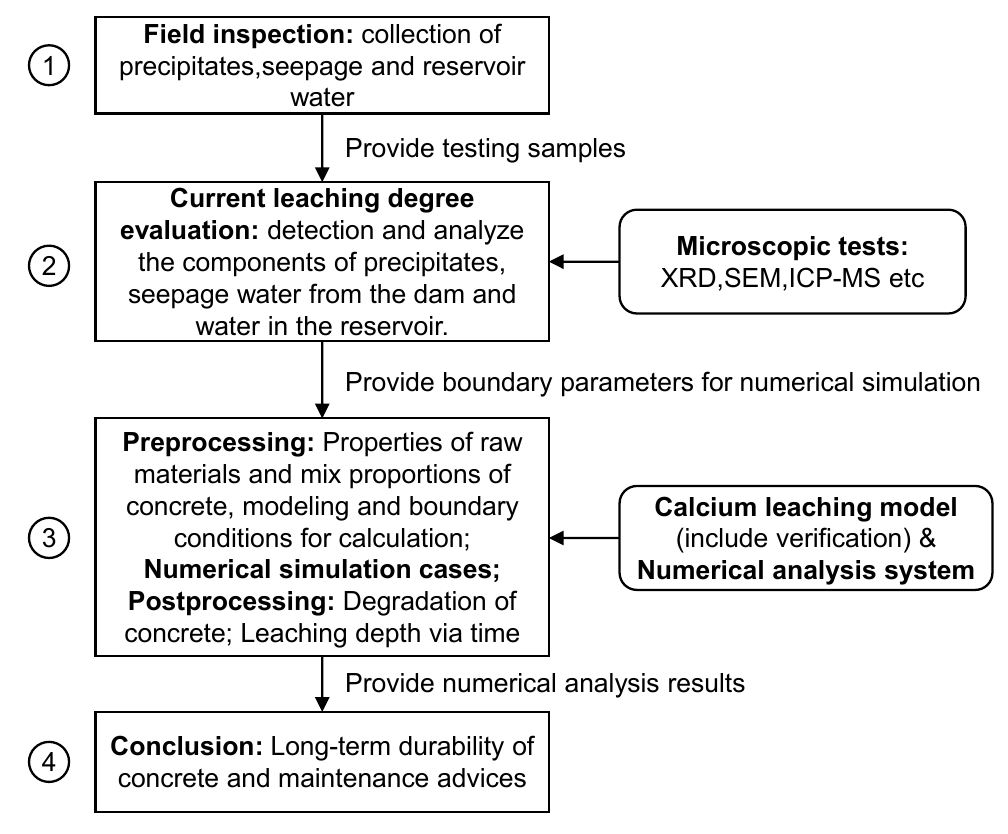
Figure 1. The total framework of methodology to evaluate the long-term durability of dam concrete due to calcium leaching.